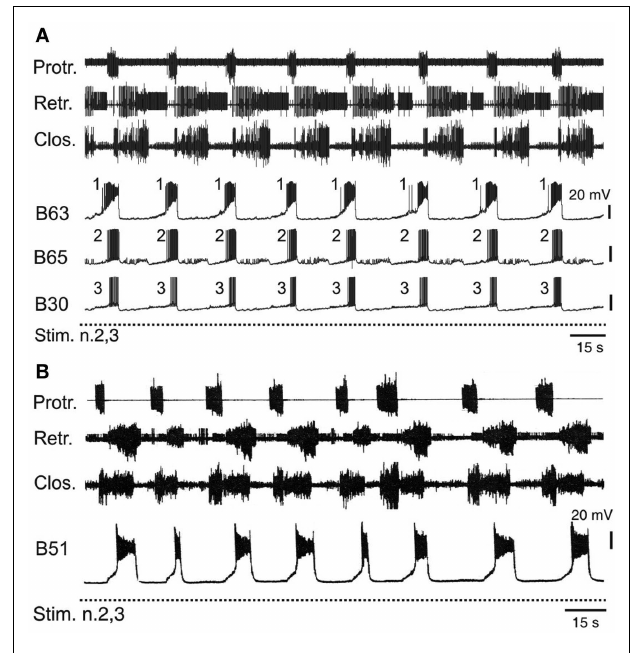
FIGURE 6 |Accelerated and stereotyped ingestive pattern genesis induced by appetitive operant learning. (A) Simultaneous recordings of radula motor patterns and underlying bursting in the anticipatory B63, B65, B30 neurons in a buccal ganglia preparation isolated from a food reward trained animal.The rhythmic expression of motor patterns was associated with regular bursting in the anticipatory neurons, with each cycle being systematically led at a brief interval by burst onset in B63 (c.f. Figure 4B ). (B) The regularization of ingestion pattern expression in an in vitro analog of appetitive learning was also associated with a systematic participation of B51 bursting in buccal CPG functioning. Compare with Figure 5A